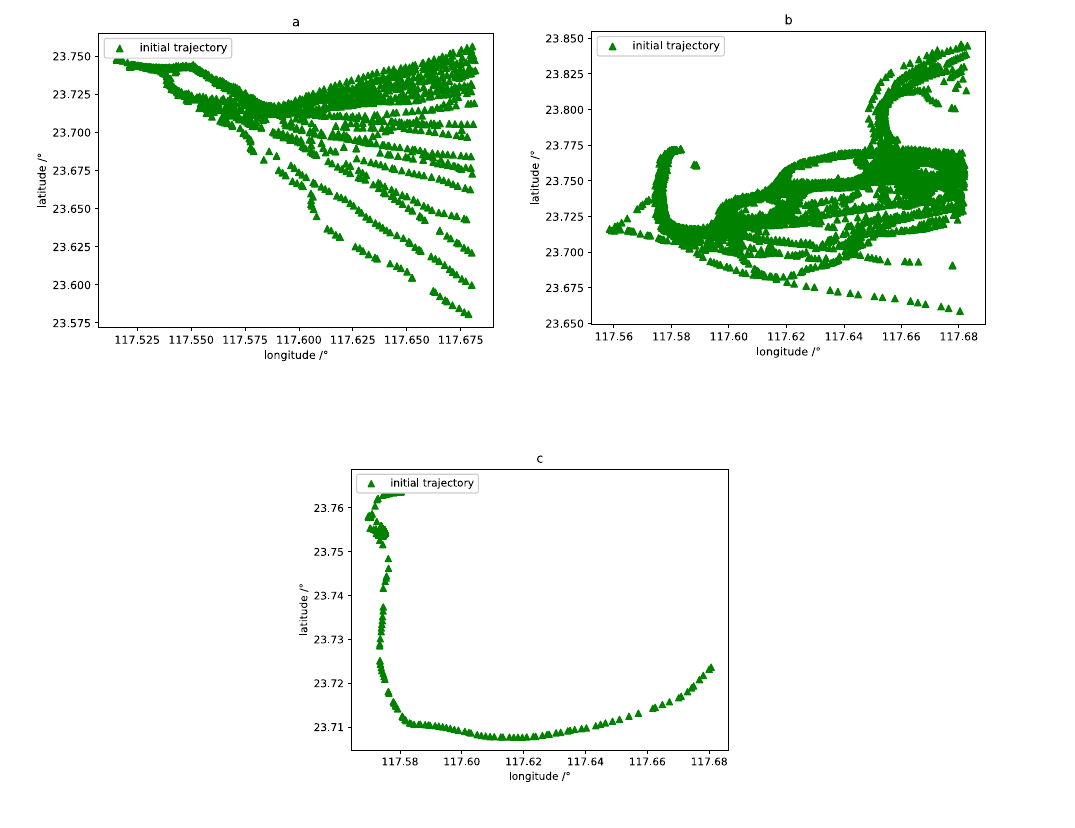
Figure 9. The three representative common vessel trajectories: ( a ) straight trajectory entering a port; ( b ) circuitous trajectory in narrow seas; and ( c ) trajectory with large turns in wide seas.